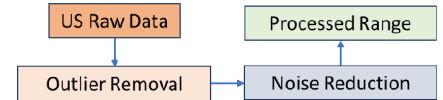
Figure 4. Flowchart of ultrasonic sensors raw data